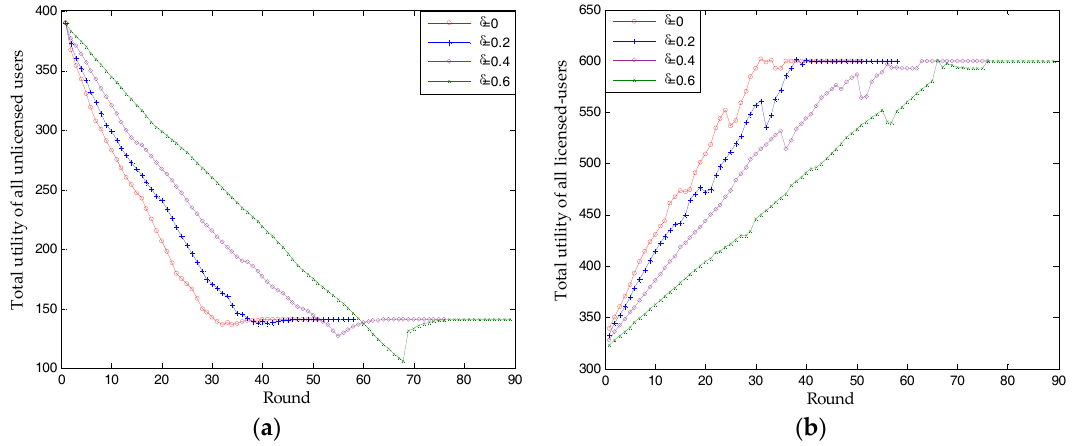
Figure 9. The influence of all unlicensed users being dishonest: ( a ) utility of all unlicensed users; ( b ) utility of all licensed users.